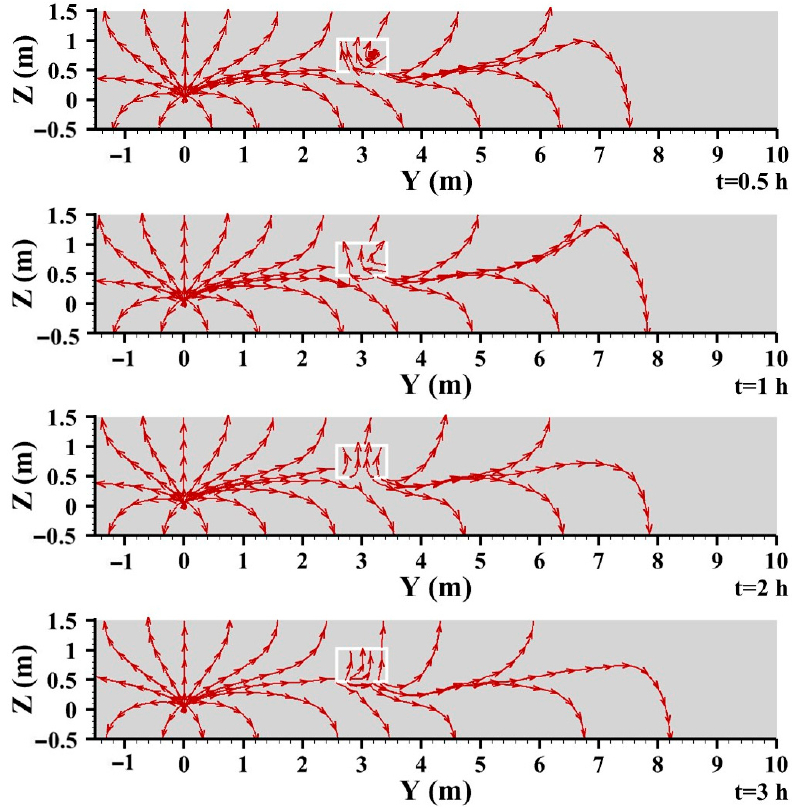
Figure 9. Cloud diagram of streamline distribution with different leakage time on plane X = 0.